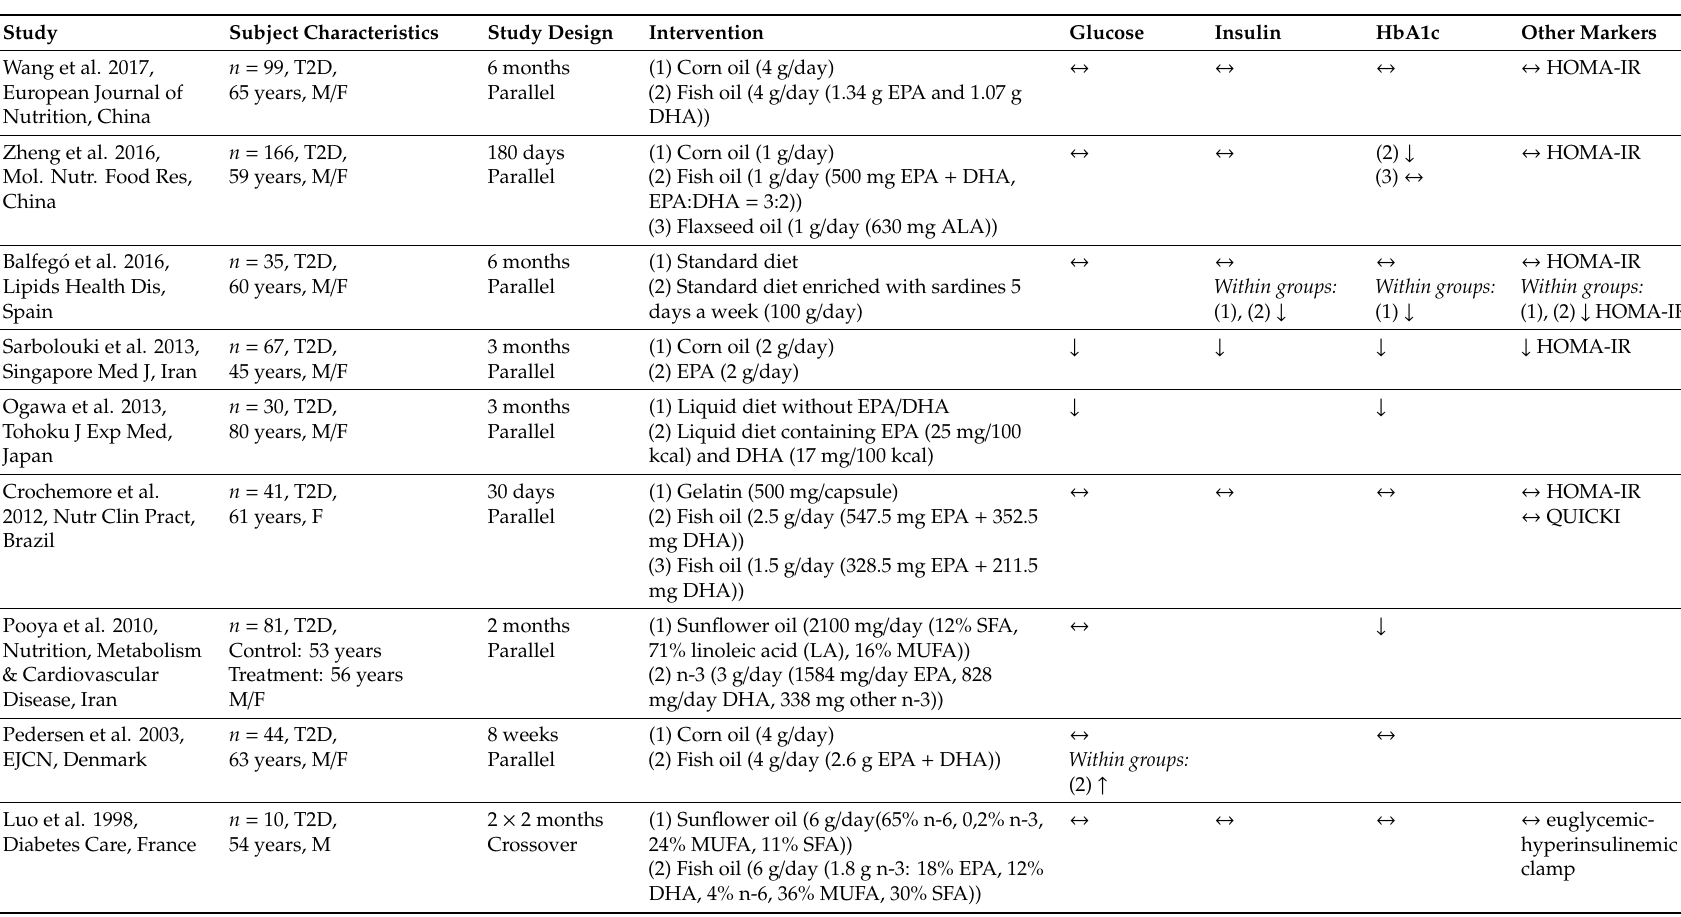
Table 1. E ff ects of fish and fish oil on glycemic regulation in type 2 diabetes in randomized controlled trials. Significant results are indicated by an up / down